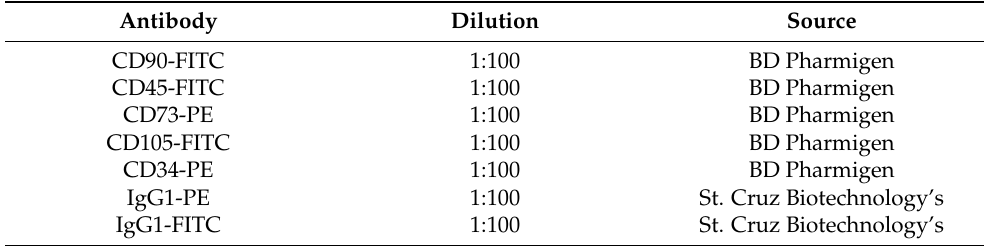
Table A2. List of antibodies.